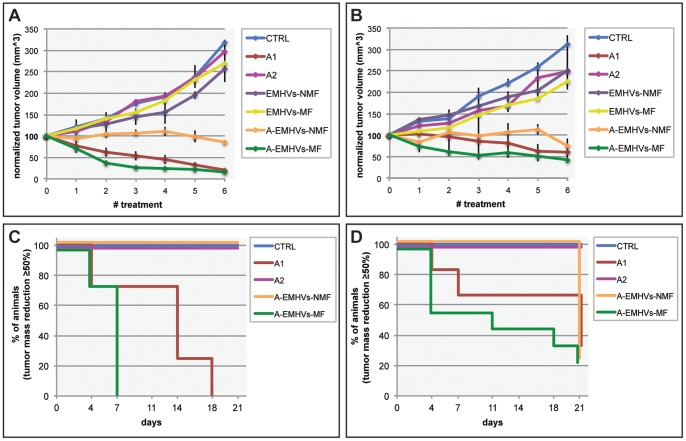
The anticancer effect of A-EMHVs treatment in vivo.Mass tumour growth curves for all experimental group are depicted in panel A and B. The treatments are Control (CTRL, cyan); therapeutic dose (A1, red); low dose equivalent to that inside the erythrocytes (A2, purple); EMHVs and no magnetic field applied (EMHVs-NMF, blue); EMHVs undergoing magnetic field (EMHVs-MF, yellow); loaded EMHVs and no magnetic field applied (A-EMHVs-NMF, orange); loaded EMHVs undergoing magnetic field application (A-EMHVs-MF, green). In (A) LNCap xenograft, the most significant mass reduction was measured both in A-EMHVs-MF and A1, while other treatments exerted intermediate effect with respect to controls (One-Way ANOVA p<0.05 at time of the sixth injection). In (B) DU145 xenograft, mass showed a similar trend with A-EMHVs-MF and A1 treatments being the most effective (One-Way ANOVA p<0.05). In C and D, Kaplan-Meier estimator curve was used to determine the percentage of treated mice showing a reduction of tumour mass volume (≥50%) during treatment. In (C) the trend of reduction is depicted for LNCap xenograft model: 100% of animals show ≥50% tumour volume reduction after A-EMHVs-MF (day 7th) and A1 (day18th) treatments. In DU145 xenograft model (D), A-EMHVs-MF (green) is the most effective anti-tumour treatment (e.g. CTRL or A2 vs A-EMHVs-MF, log rank = 4.52 at day 21st).